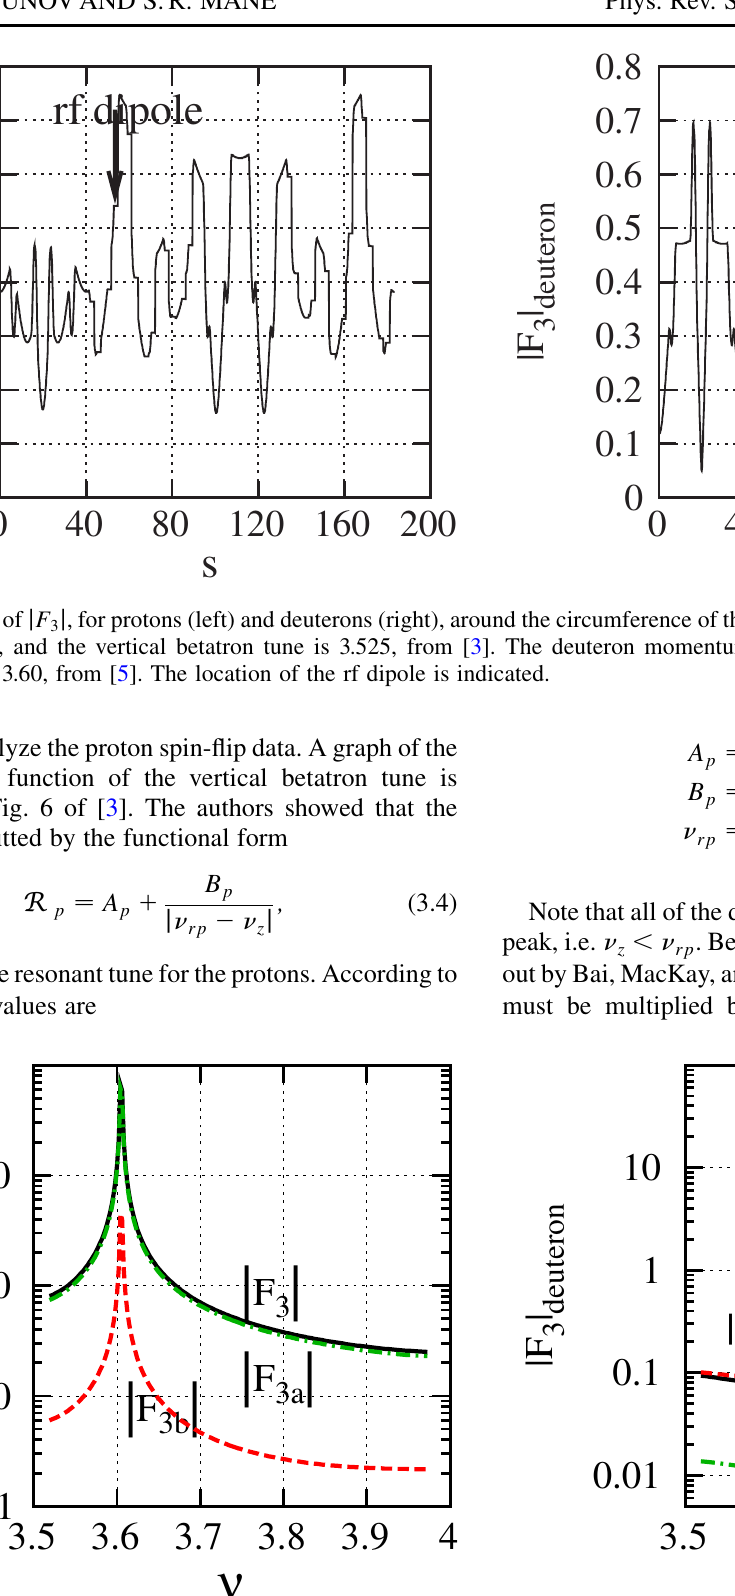
, for polarized protons (left) at z and F 3 are the individual contributions to F 3 a b